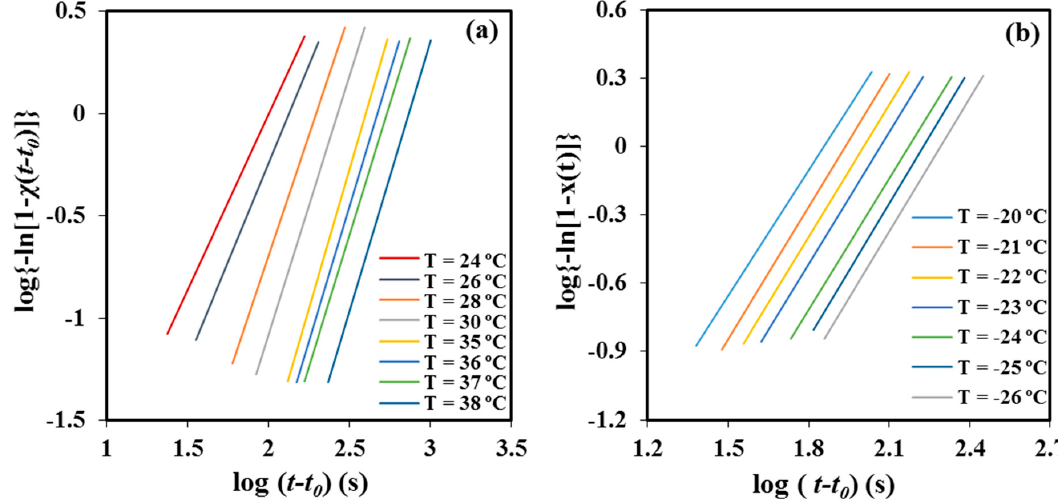
Figure 8. Avrami plots obtained from isothermal melt ( a ) and cold ( b ) crystallizations. Z and k values evaluated from both kinds of crystallizations are also summarized in Table 1.